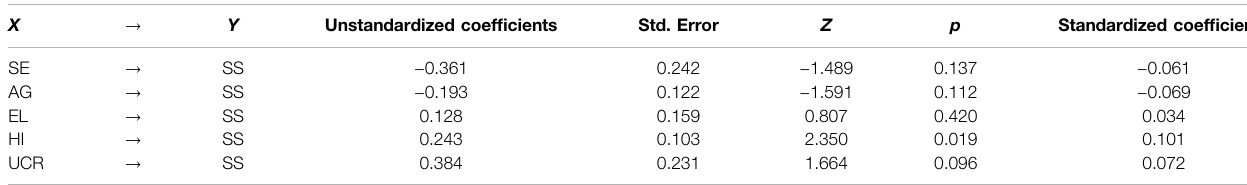
TABLE 6 | Path analysis: demographic variables and sustainability.